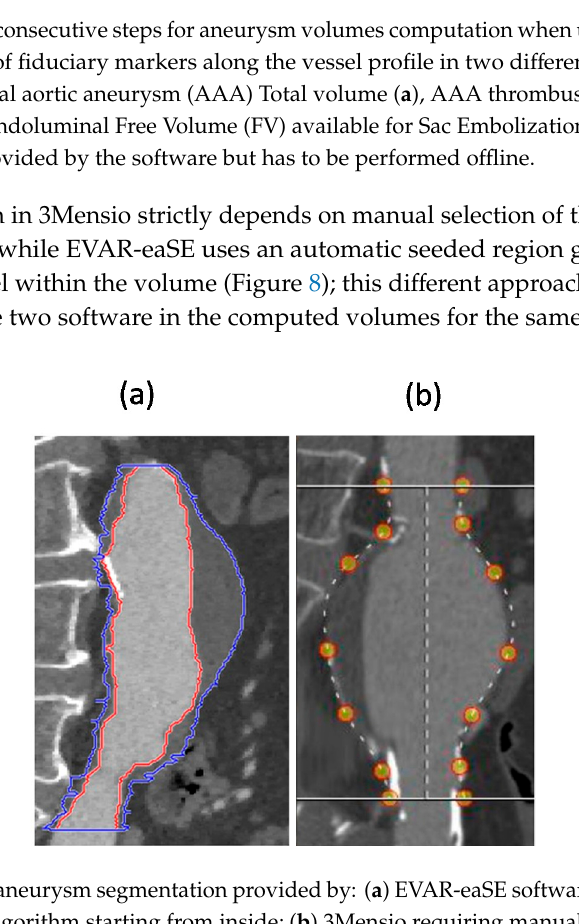
Figure 8. Example of aneurysm segmentation provided by: ( a ) EVAR-eaSE software using an automatic seeded region grow algorithm starting from inside; ( b ) 3Mensio requiring manual selection of markers on the external sac profile.